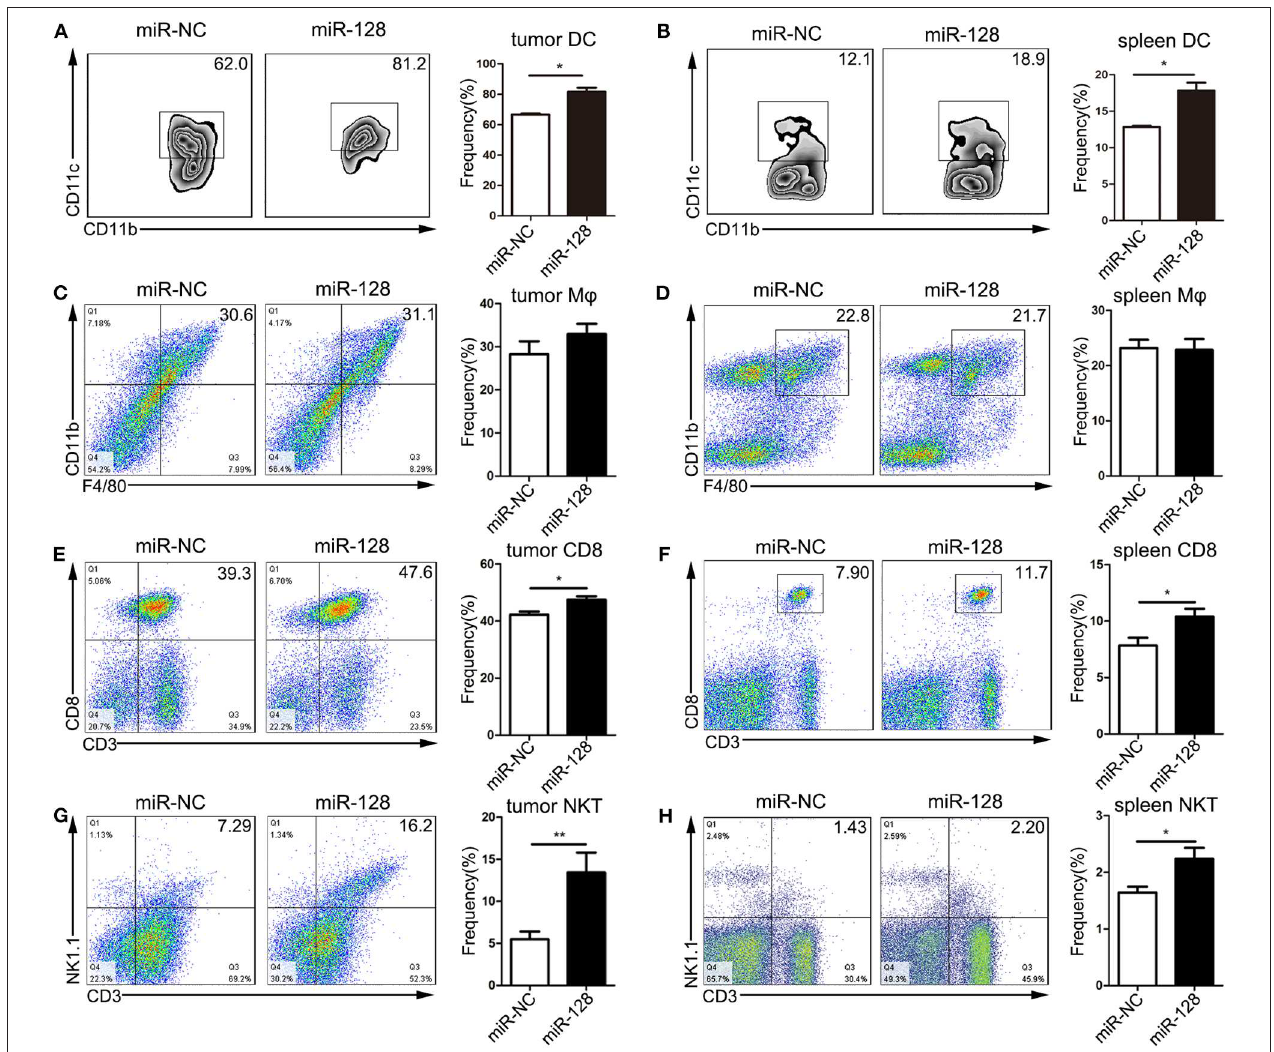
FIGURE 3 | Overexpression of miR-128 enhanced anti-tumor immunity. The tumors and spleens were isolated from in situ pancreas-tumor-bearing mice and stained for flow cytometry analysis. The dendritic cells (DCs) (A,B) , macrophages (C,D) , CD8 + T cells (E,F) , and natural killer T (NKT) cells (G,H) were analyzed by flow cytometry analysis. The results represent the mean ± SEM from three independent experiments. Comparisons between groups were determined by Student’s t -test. * p < 0.05, ** p <